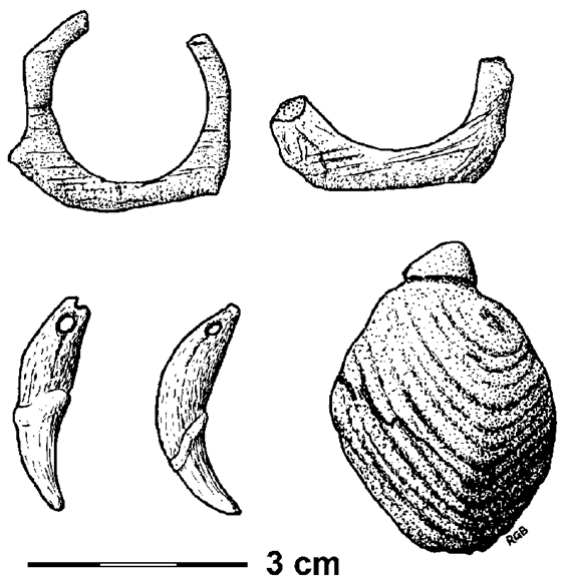
Figure 10. Some of the jewelry from the Châtelperronian of Grotte du Renne, Arcy-sur-Cure, Yonne, France, made by